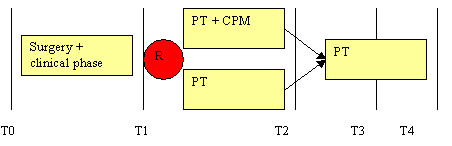
study design. Legend to figure 1: T0 one week before surgery. T1 4 days after surgery. T2 17 days after surgery. T3 6 weeks after surgery. T4 3 months after surgery.